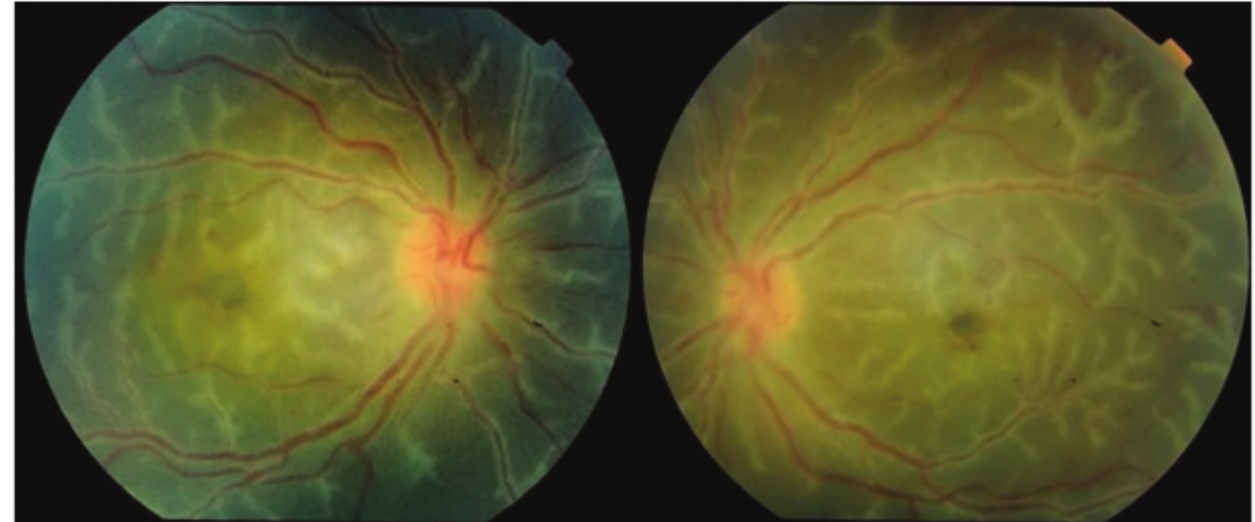
Figure 1. Bilateral primary idiopathic frosted branch angiitis in a 5-year-old boy. Note the prominent, florid, translucent, retinal perivascular sheathing affecting both the venules and arterioles. The sheathing originates from the posterior pole and extends up to the periphery.